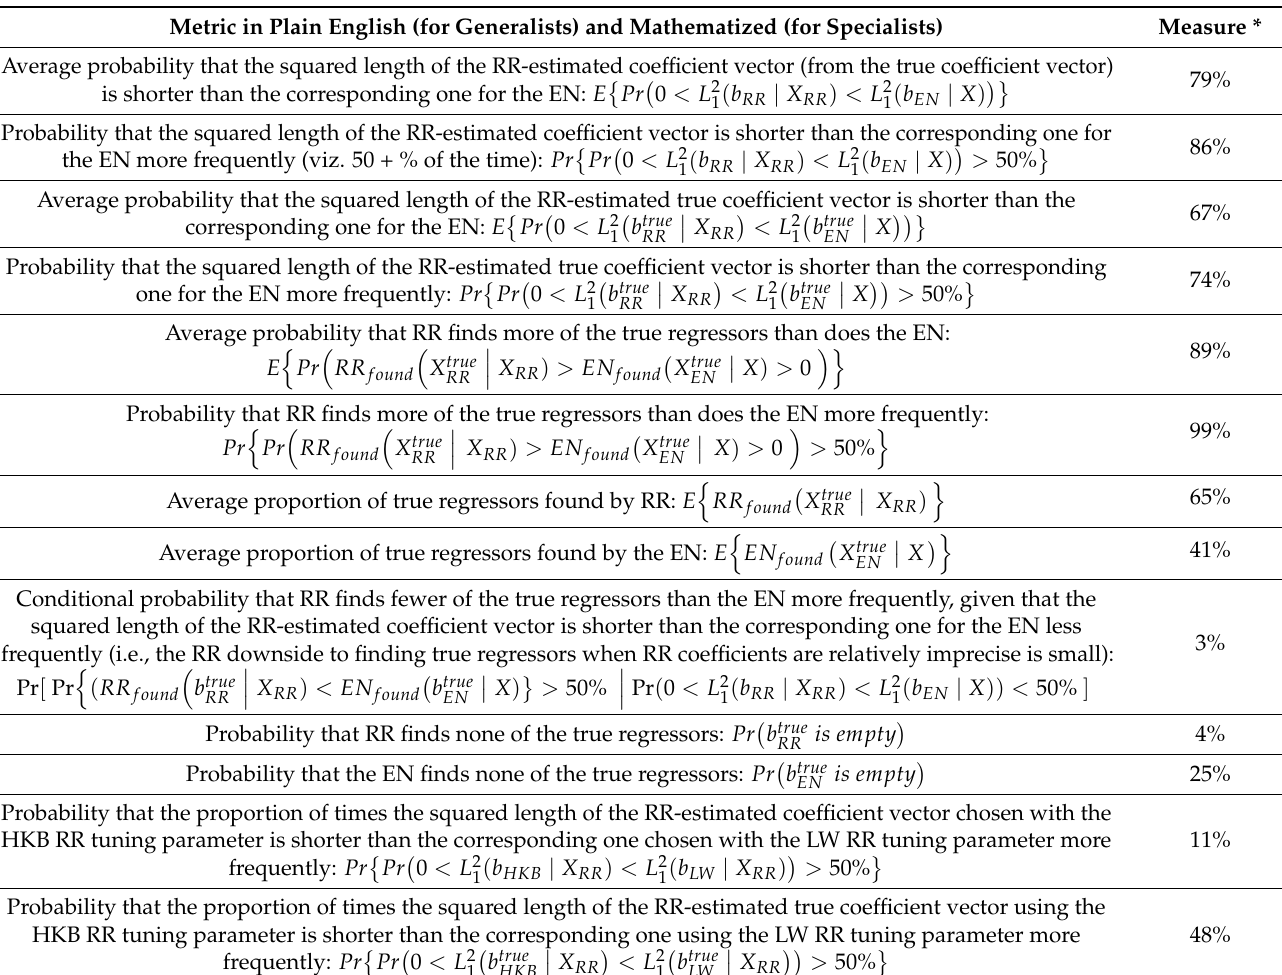
Table 1. Metrics measured and summarized across all simulation